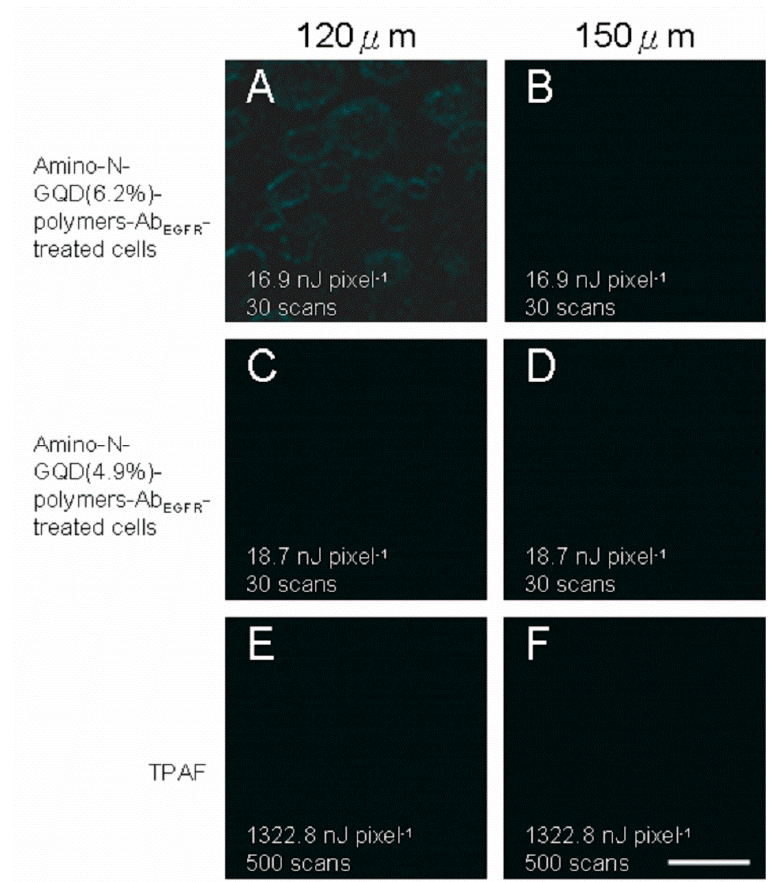
Figure 8. ( A – D ) TPI results (cyan in color) of the nanomaterial-polymer-Ab EGFR -treated cells and ( E , F ) TPAF imaging results of the unlabeled cells at di ff erent depths ranging from 125 to 150 µ m (with a constant increment) and TPE powers of 16.9, 18.7 nJ pixel − 1 (30 scans), and 1322.8 nJ pixel − 1 (500 scans) (Ex: 800 nm). The delivered dose of the material was 4 µ g mL − 1 in cell culture medium, and the scale bar is 20 µ m.